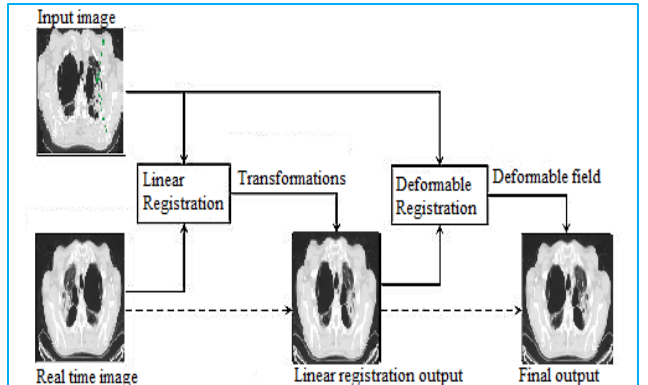
Figure 9. Registration process.